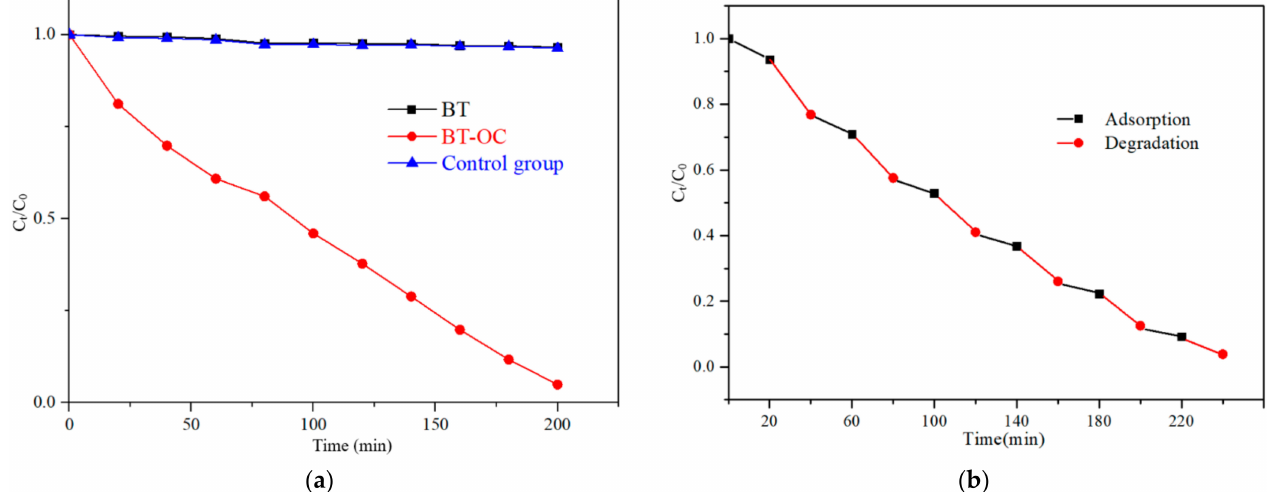
Figure 7. ( a ) Degradation effect curves of RhB with the different samplesunder UV irradiation. ( b ) The adsorption- degradation effect curve of RhB with